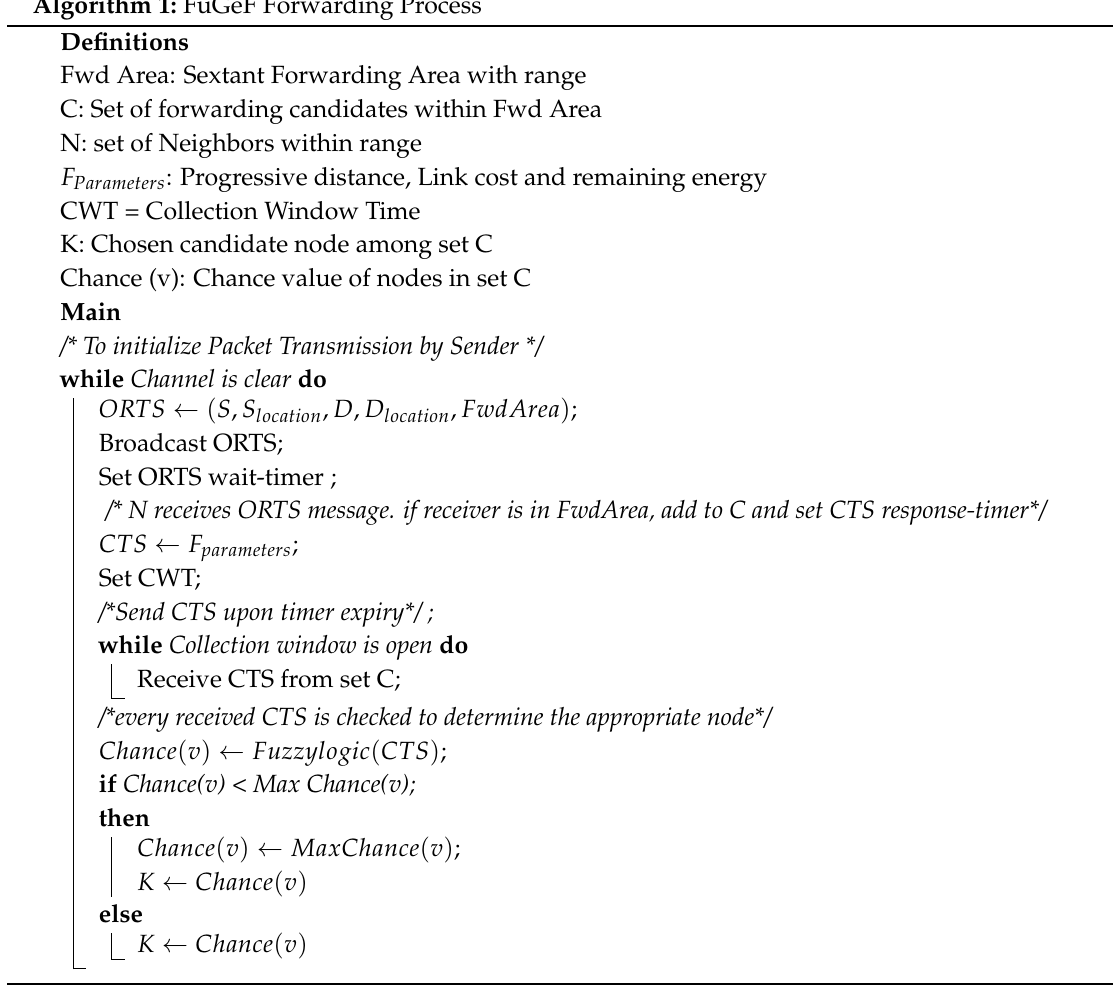
Algorithm 1: FuGeF Forwarding Process